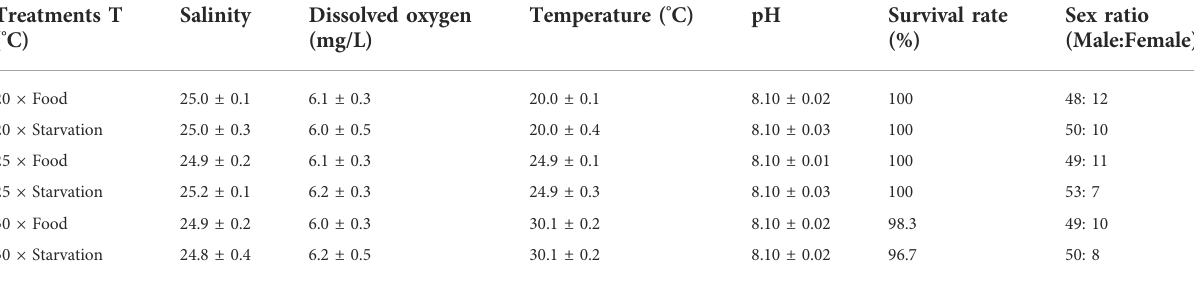
TABLE 1 Chemistry parameters (mean ± SD, n = 30) of seawater during the experiment. Temperature (T, ◦ C) was measured continuously during the wholeexperiment.Dissolvedoxygen(mg/L),salinity,andpHweremeasuredateveryday.Mortalitywascountedthroughouttheexperiment,and the survival rate (%) was calculated in the end. The sex ratio was determined at the end of experiment (totally 60 mussels in each treatment). Treatments T ( °